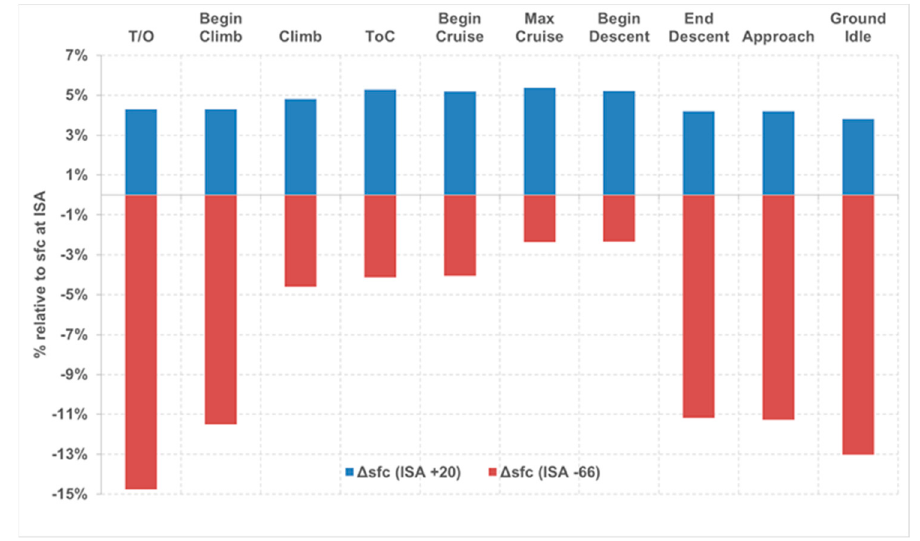
Figure 8. SFC variation due to ambient conditions.